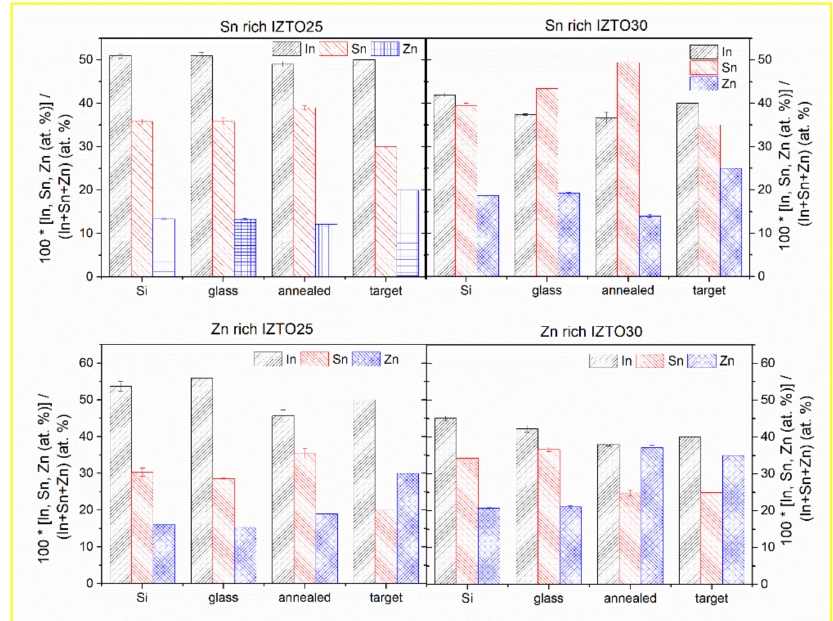
Figure 8. Actual composition of In, Sn, and Zn for non-stoichiometric IZTO films deposited onto the glass and SiO 2 /Si substrates and annealed non-stoichiometric IZTO films onto the glass substrates obtained by EDS, together with expected (target) composition. Sum of at.% of In, Sn, and Zn is taken as